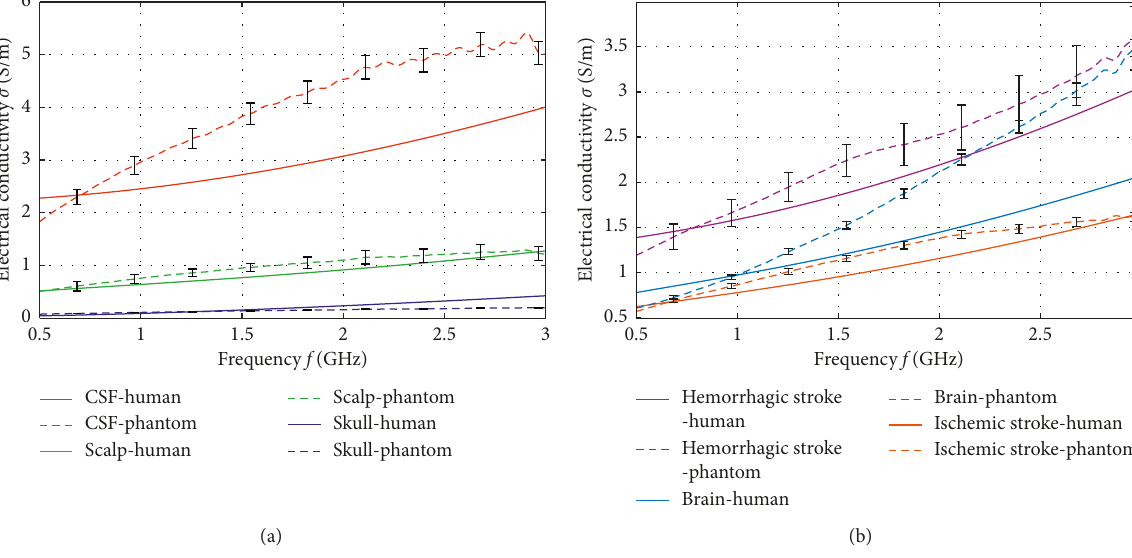
Figure 5: Frequency dependence of the human head phantom electrical conductivity with extended uncertainties ( k � 2): (a) scalp, skull and CSF solid phantom layers; (b) liquid brain and solid stroke phantom